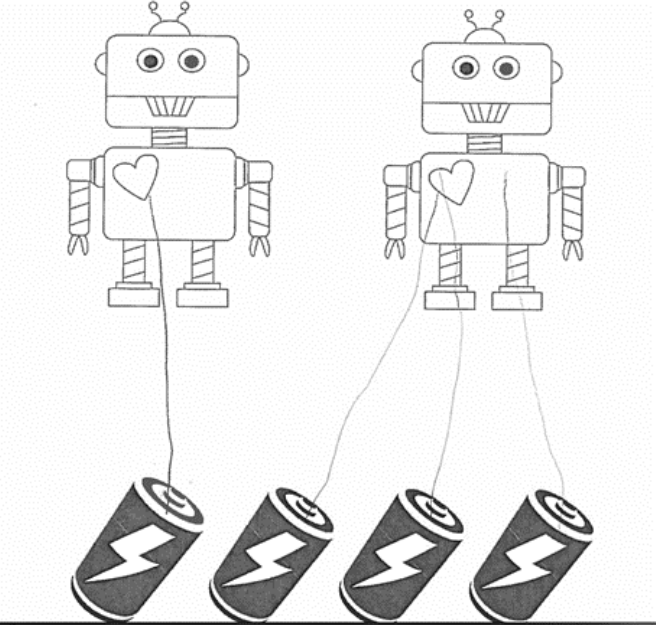
Figure 2. Example of an incorrect mathematics story response. Note. Student work showing an incorrect distribution of four batteries to two robots. This response received a score of 5, meaning that the batteries were all distributed correctly as wholes, but not fairly.